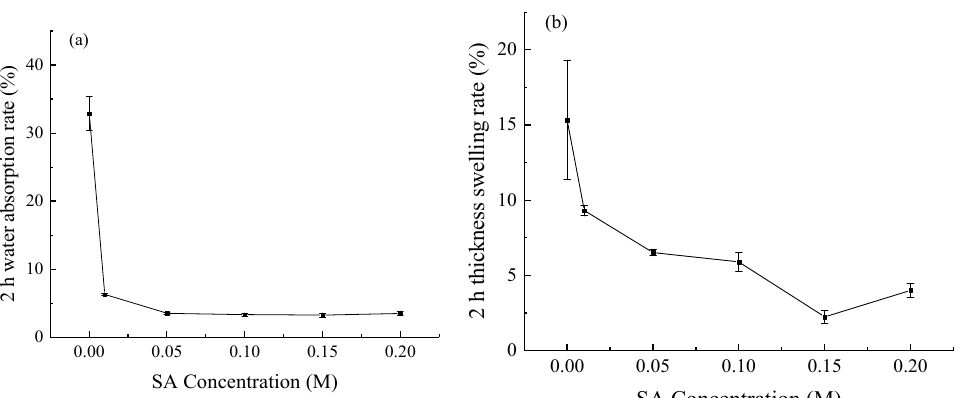
Figure 8. The 2 h water absorption rate ( a ) and 2 h thickness swelling rate ( b ) of NP/HDPE composite with different SA concentrations.